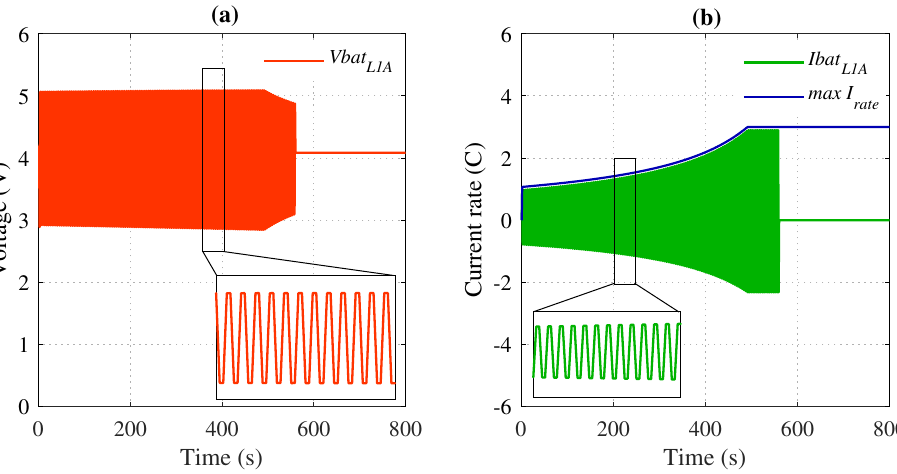
Figure 11. ( a ) Voltage response and ( b ) current response for one cell with f pulse = 1 Hz.